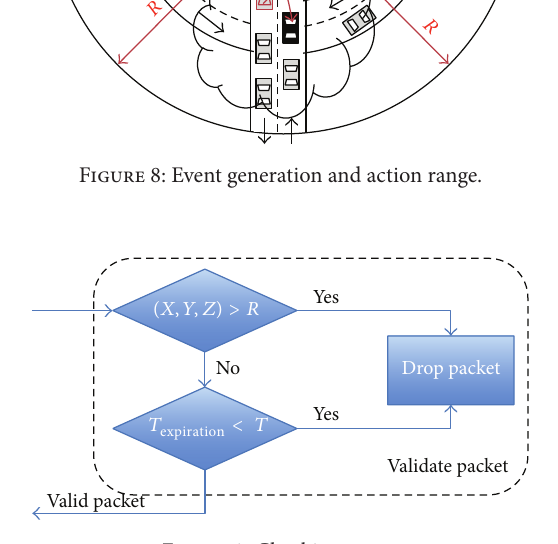
Figure 9: Checking event.